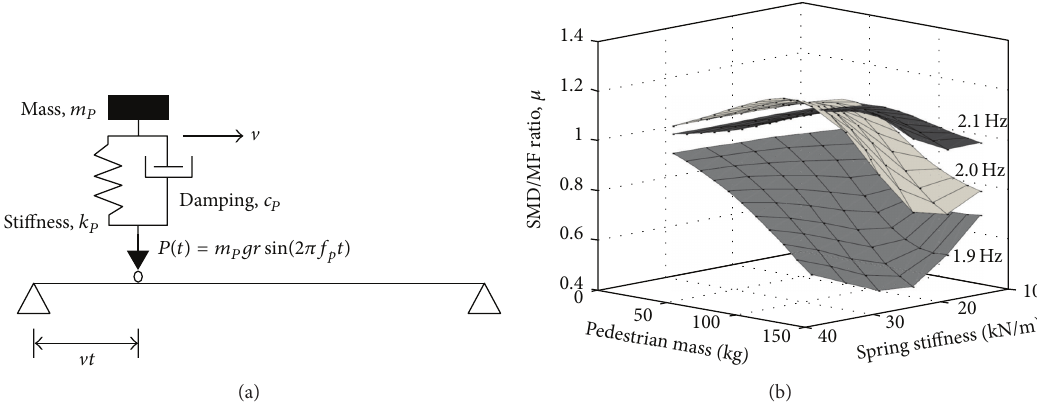
Figure 3: (a) Moving mass-spring-damper model coupled with walking GRF and (b) ratio of the response of interactive/force-only models